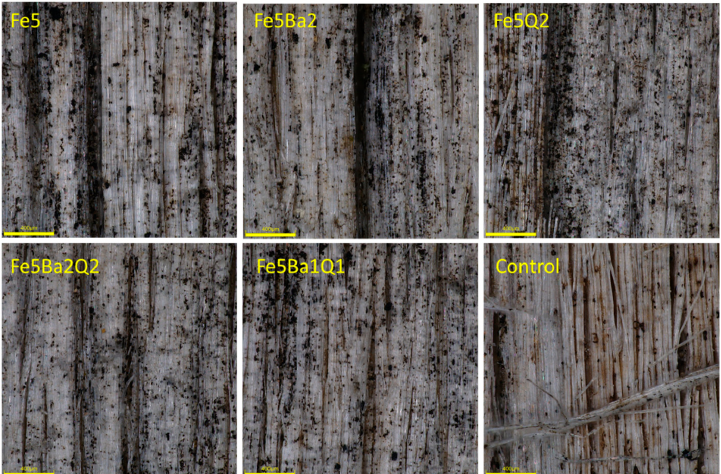
Figure 6. Surface of control and treated Norway spruce samples after 172 weeks of outdoor exposure. Control bars are 400 µm in length.